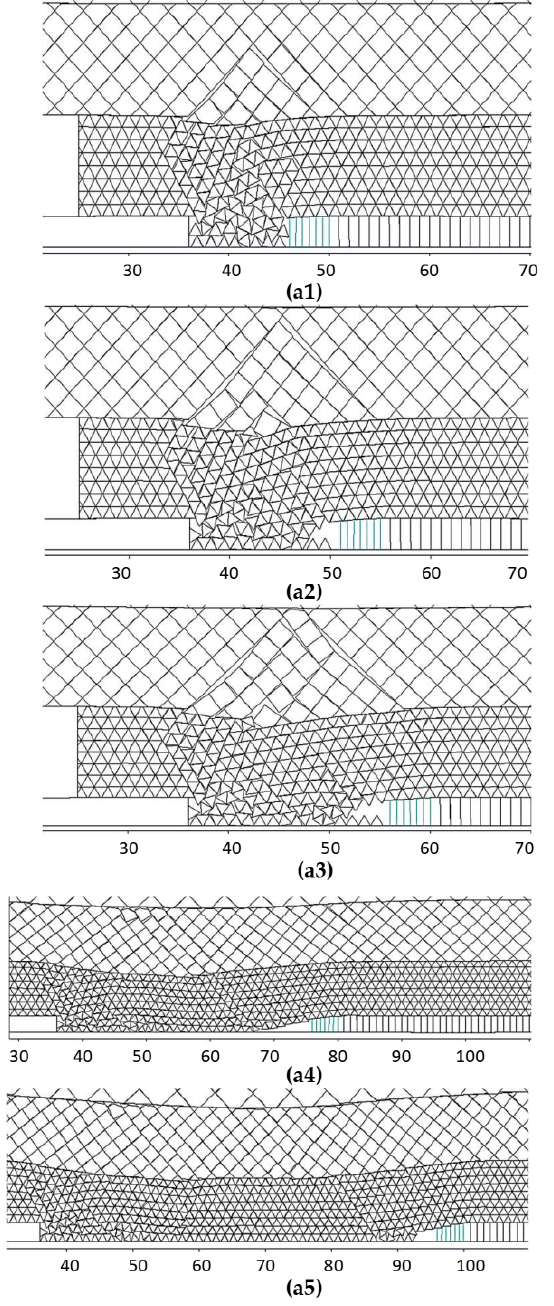
Figure 8. The state of the modeled rock mass at chosen stages of the simulation: ( a ) variants with DHF, ( b ) variants without DHF. 354